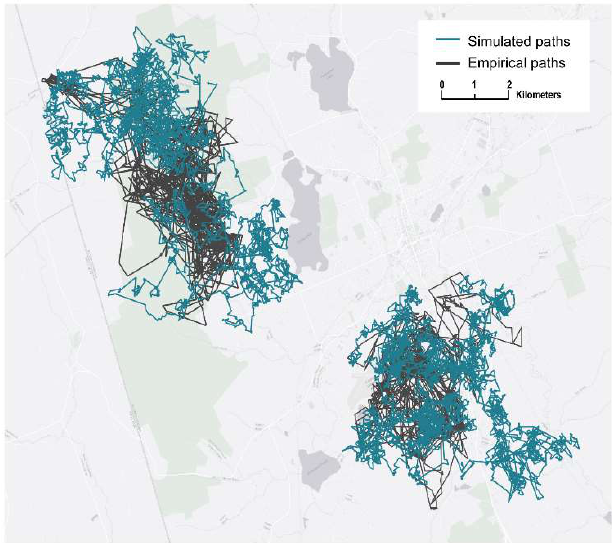
Figure 3. Examples of empirical black bear paths (in black) and simulated black bear paths in the same area (in blue). The background map shows roads in white, water bodies in dark grey and conserved lands in green.